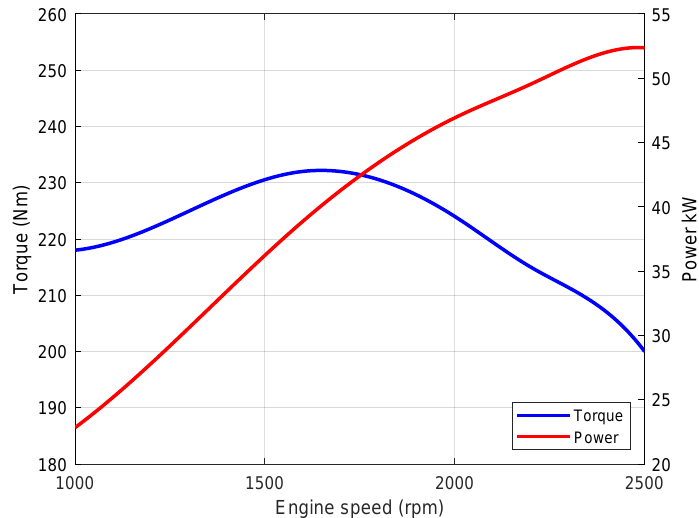
Figure 5. Torque and power characteristics for diesel engine of HeCVT tractor.